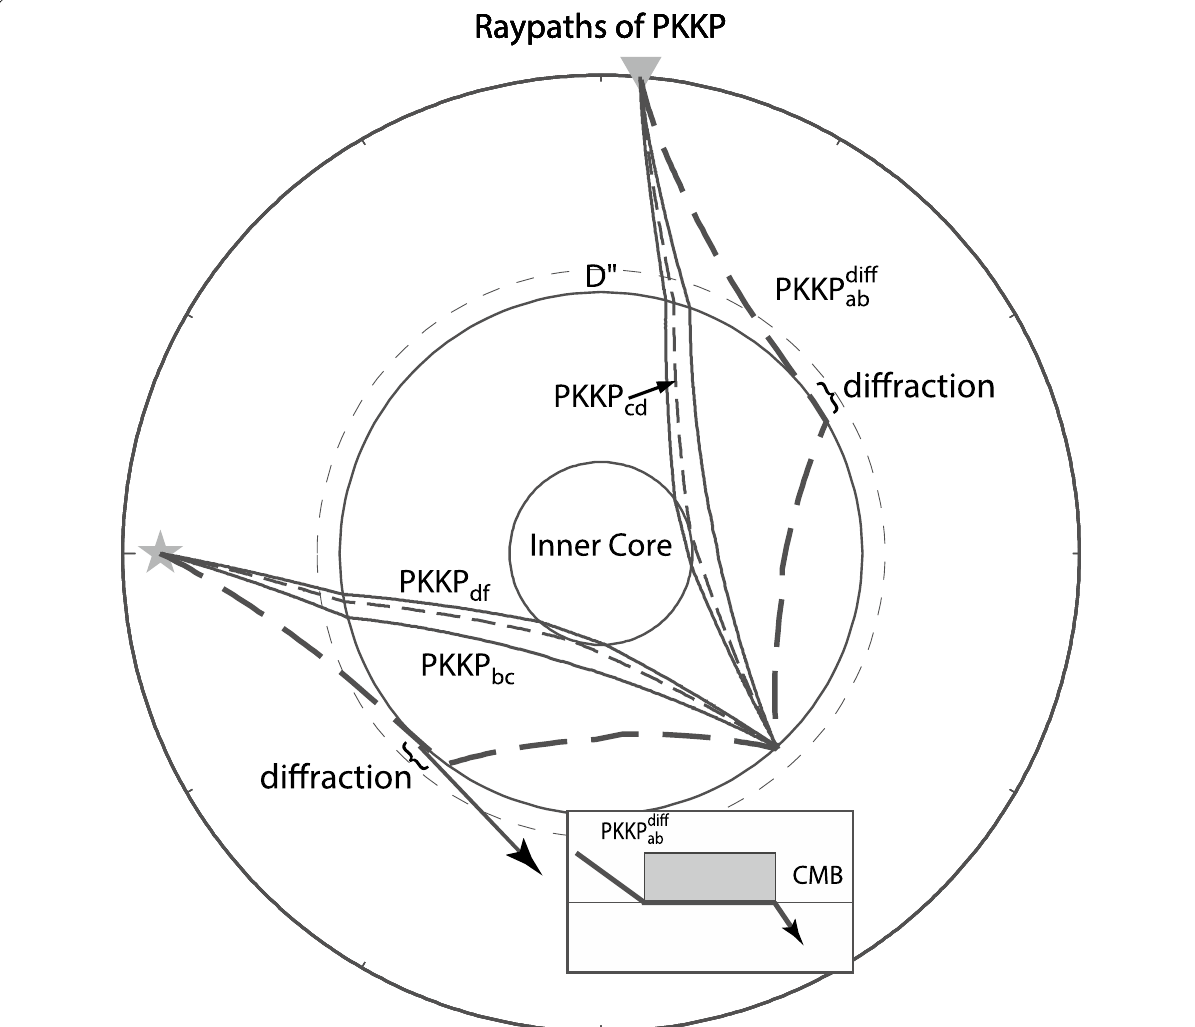
Fig. 1 Raypaths for different PKKP branches. PKKP df and PKKP bc raypaths are denoted as solid lines, and PKKP cd as well as PKKP ab diffraction paths are denoted as thinner and thicker dashed lines, respectively. The ray paths are generated for an event ( gray star ) with a focal depth of 500 km, and the minor epicenter distance to the station ( gray inverted triangle ) is 95°. The diffracted portions along the core–mantle boundary on the two sides are about 9.0° in total. The inserted box shows one-sided diffraction of PKKP ab waves along the